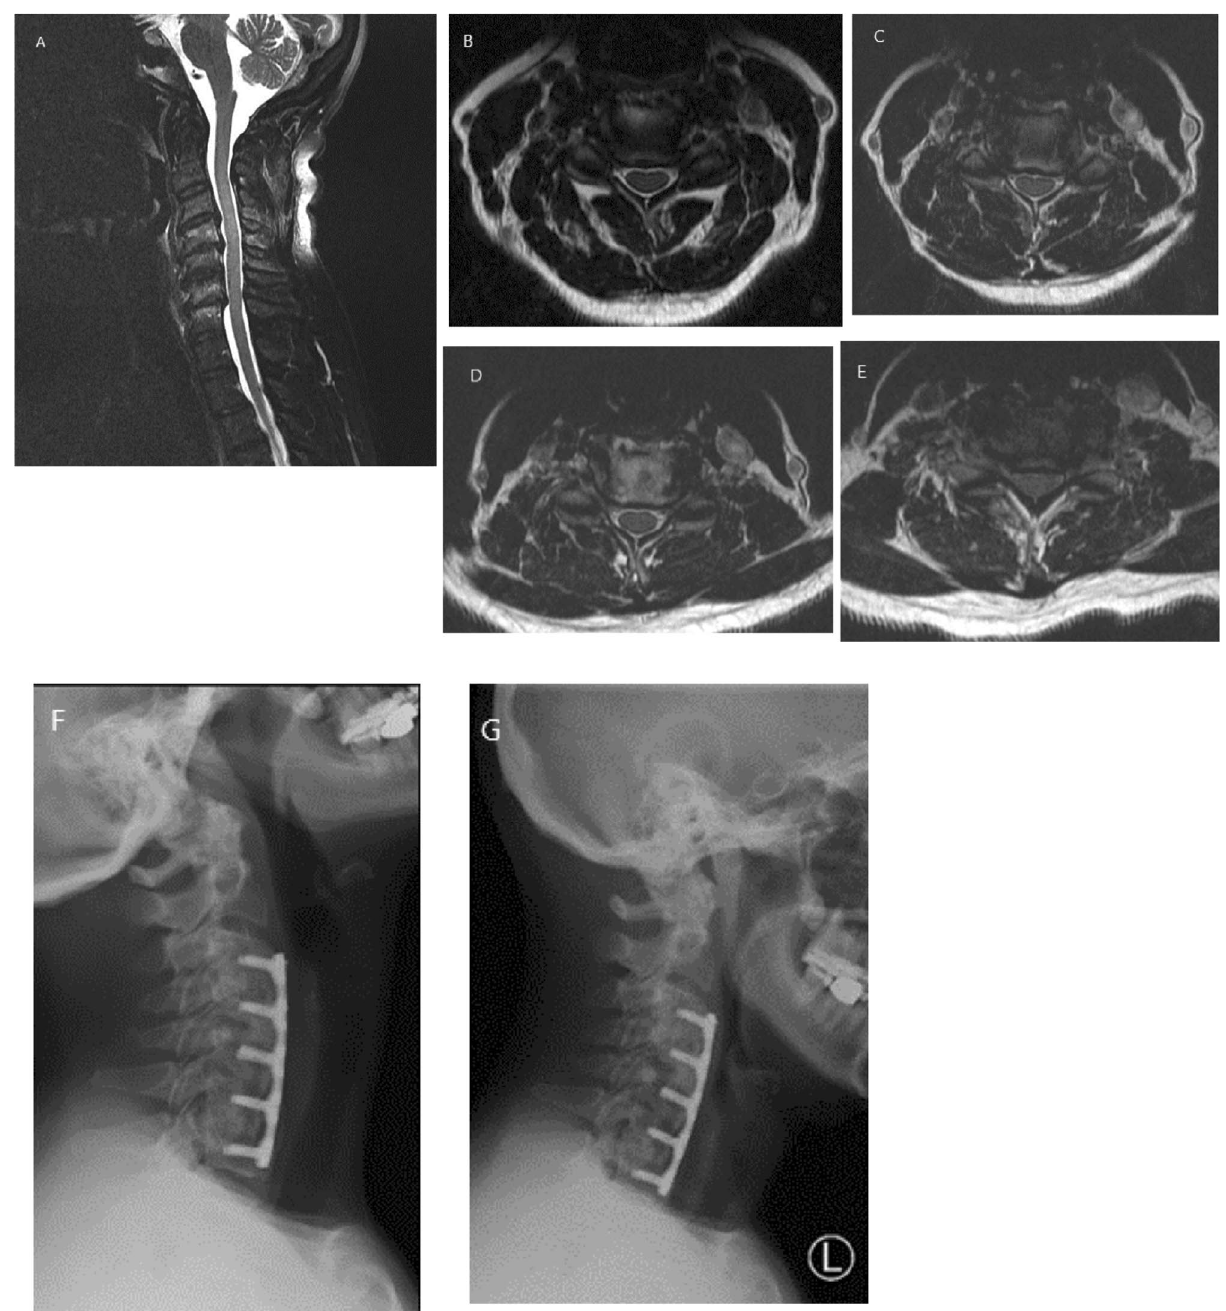
Figure 1. A 57-year-old female with longstanding history of neck pain. Over the past few years, she has also started to notice a gradual decrease in dexterity and numbness in her hands. T2-weighted sagittal and axial magnetic resonance imaging (MRI) scans ( A – E ) showed multilevel cervical stenosis at the interspace levels C3– C7. The patient underwent a four-level ACDF at the levels C3–C7 with excellent clinical outcome. At the last follow-up, lateral flexion/extension X-rays of the cervical spine ( F , G ) showed good alignment and solid fusion across each disc